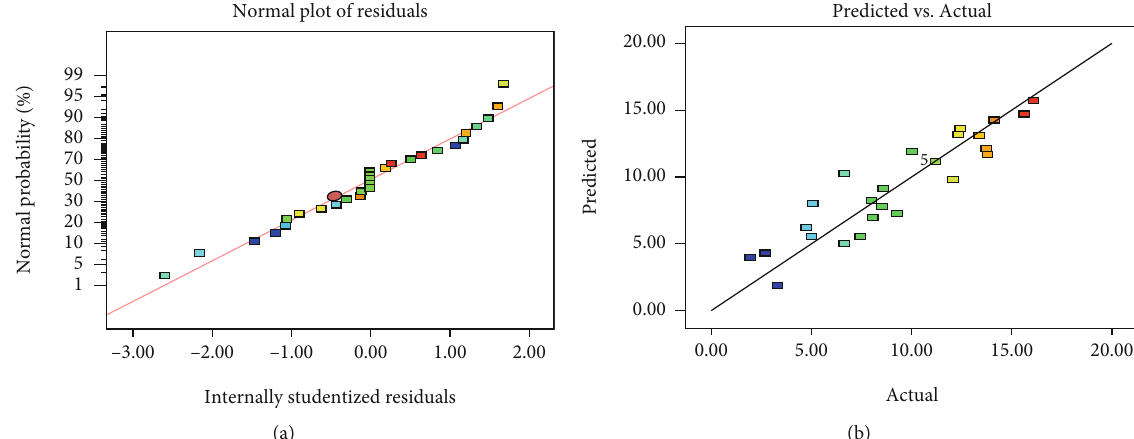
Figure 7: Illustration of the reliability of the response model to the frost heaving force. (a) Internally studentized residual distribution for the FHF value. (b) Comparison of the predicted FHF and the actual